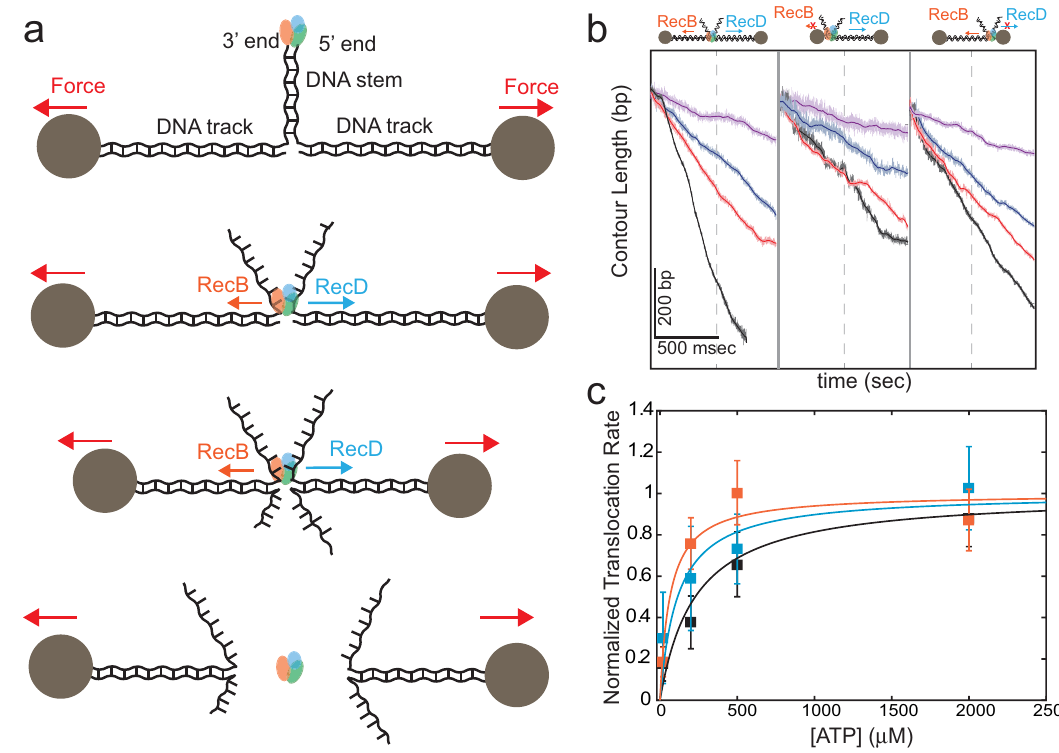
Fig. 2 Single-molecule measurements of translocation by RecBCD and its individual subunits. a Schematic representation of the experimental optical tweezers setup. RecBCD binds to and translocates on a DNA stem connected to beads through DNA “ tracks ” . Upon reaching the fork, the helicase subunits translocate in different directions due to their opposing polarities, shortening the tether length. The force increases up to a point where RecBCD dissociates from the construct. b Representative traces of translocations on three constructs probing both translocases (left, symmetric tracks of 600 bp), RecD (middle, asymmetric tracks of ∼ 30 nt/ ∼ 4000 bp), and RecB (right, asymmetric tracks of ∼ 4000 bp/ ∼ 30 nt) at different ATP concentrations (black, 2 mM; red, 500 μ M; blue 200 μ M; purple, 50 μ M). Light colors display the raw, 2.5 kHz data, and bold lines a moving average of 100 points. c Translocation rates versus [ATP] for both translocases (black), RecD (blue) and RecB (orange) in the force range 10 – 15 pN. Solid lines through the data points are fi ts to hyperbolic curves. Data are shown as mean ± s.e.m., normalized to the maximal rate according to the fi t. The number of traces used in the analysis is summarized in Supplementary Table